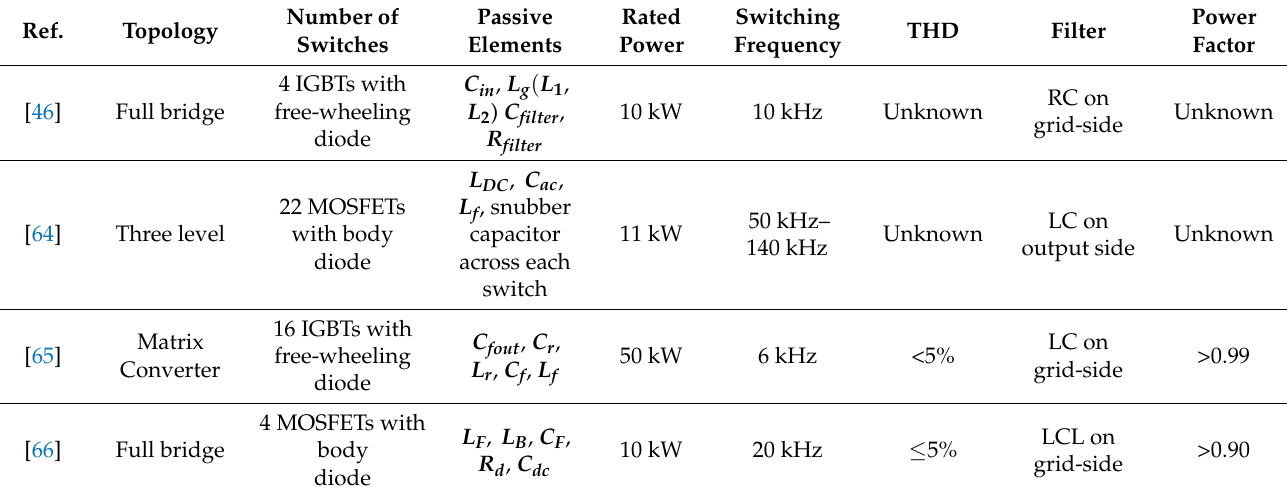
Table 3. Comparisons of various topologies for the AC-DC stages.